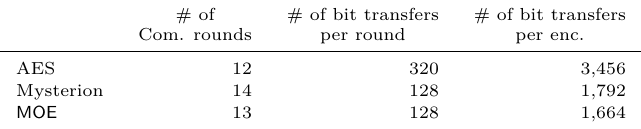
Table 4: Block cipher’s communication